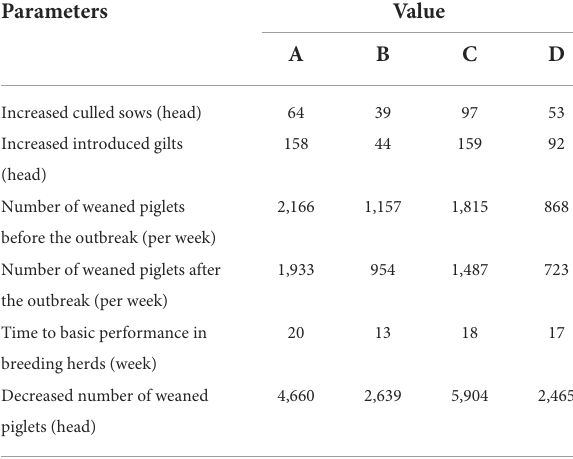
TABLE 1 The main economic parameters after the PRRS outbreak in the breeding herds.